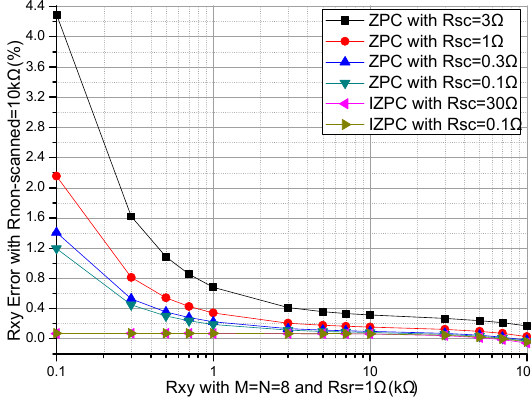
Figure 3. Effect of R sc on the R xy errors of the basic circuit and those of the improved circuit. From Figure 3, with R sc varied from 0.1–3 Ω , the R xy errors in the basic circuit showed a large change (from 1.20% to 4.29% at R xy of 0.1 k Ω ) which was more obvious with the smaller R xy ; with R sc